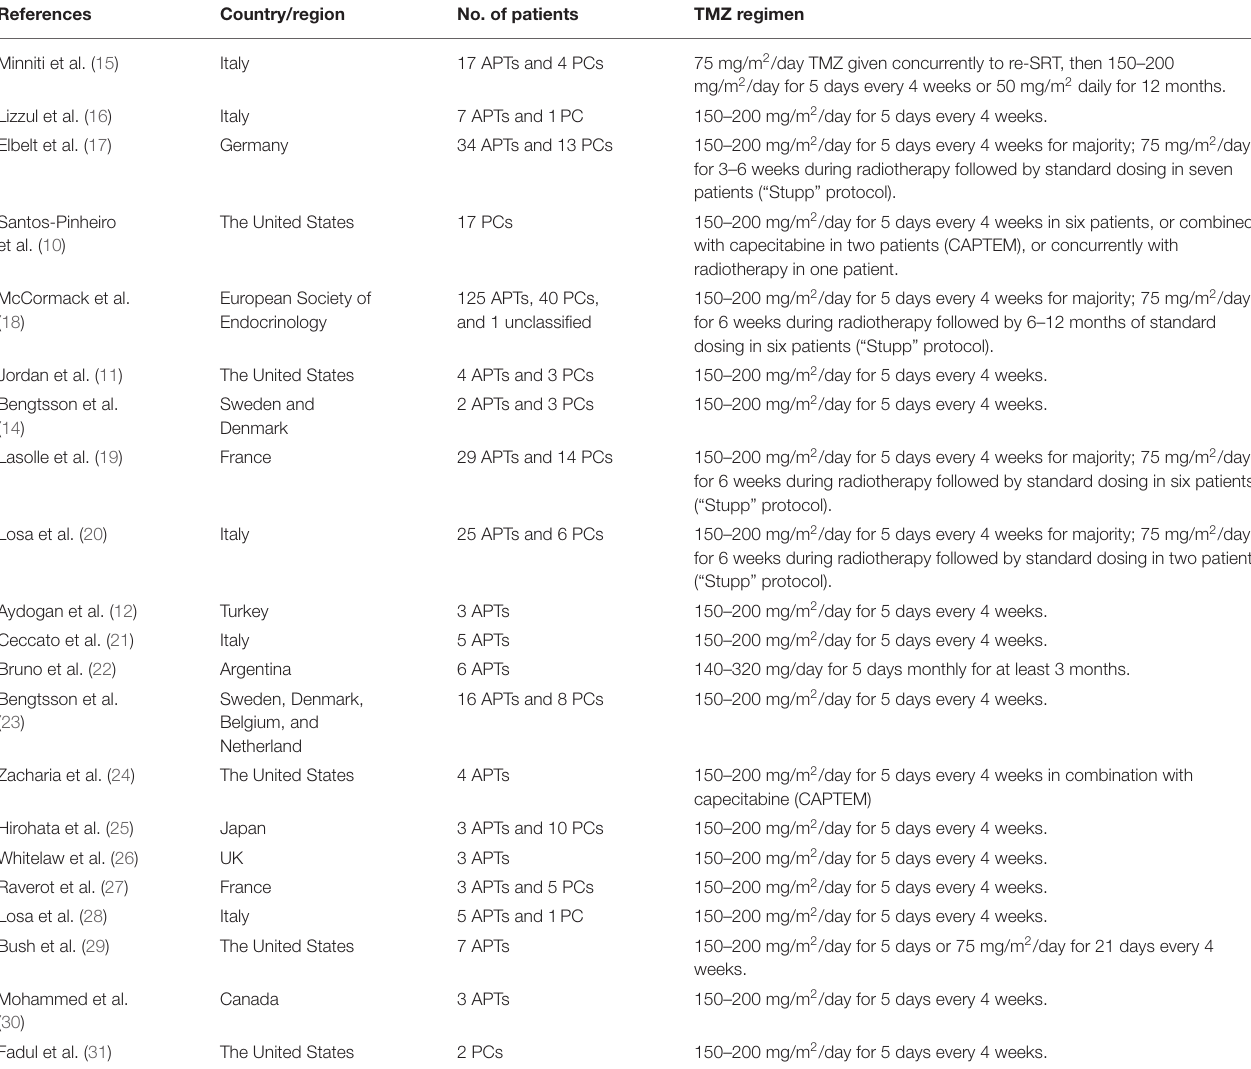
TABLE 1 | Main characteristics of eligible